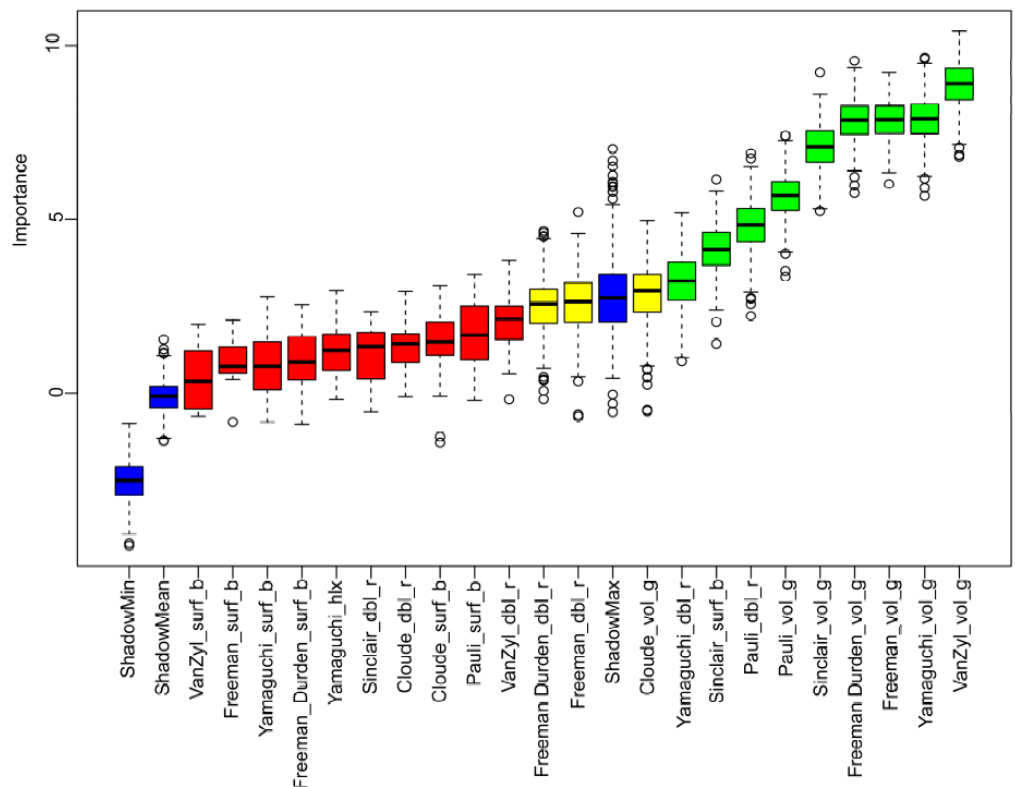
Figure 6. Importance of polarized feature components calculated by the Boruta algorithm. The blue boxplots are shadow features. Green, yellow, and red boxplots represent important, tentative, and unimportant variables, respectively.